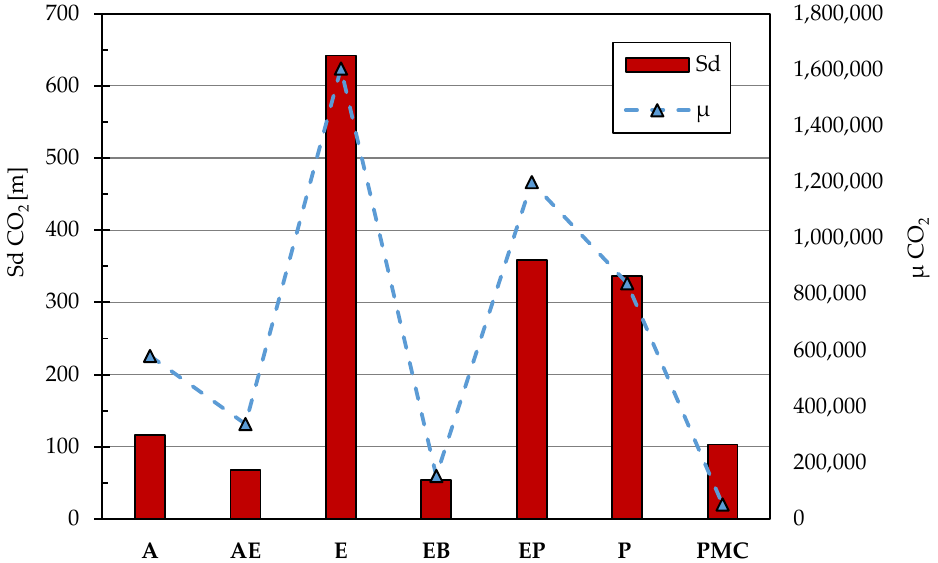
Figure 2. Resistance against CO 2 permeability of coatings expressed in terms of Sd CO 2 (left) and µ CO 2 (right). Sd CO 2 is calculated as the product of µ CO 2 and the application thickness (t).